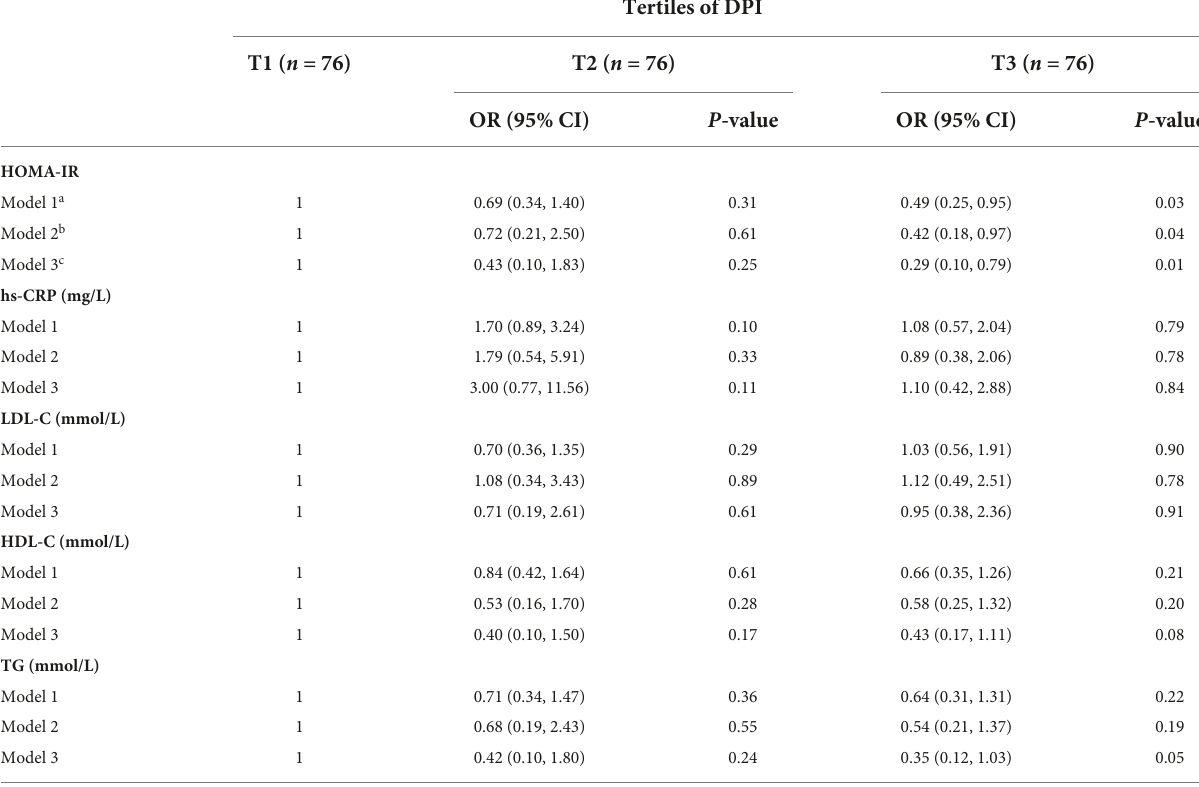
TABLE 4 Multivariate adjusted odds ratios (OR) and 95% confidence intervals (CI) for Karelis criteria components across tertiles of